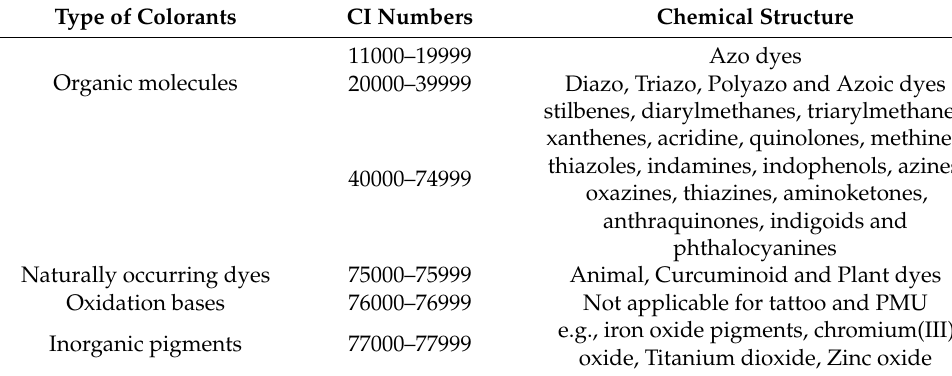
Table 2. Color index (CI) system of classification of colorants.